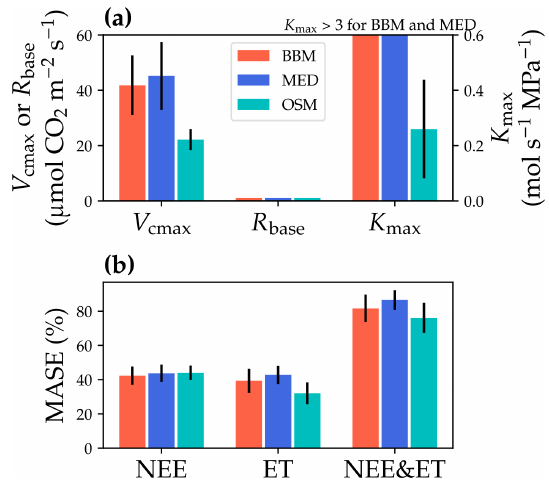
Figure 10. Comparisons of the fitted model parameters and model predictive skills for the US-NR1 (Niwot Ridge, evergreen gym- nosperm forest) flux tower. (a) The red bars plot the mean of the fitted parameters for the Ball et al. (1987) stomatal model (BBM). The fitting parameters are the maximal carboxylation rate at 25 ◦ C ( V cmax25 ), the soil respiration rate at 25 ◦ C ( R base ), and the maxi- mal whole-plant hydraulic conductance ( K max ). The blue and cyan bars plot the means for the Medlyn et al. (2011) (MED) and Wang et al. (2020) (OSM) models, respectively. Black error bars plot the standard deviation of the fitting parameter. (b) Comparison of mean absolute standardized error (MASE, Eq. 12) for the carbon flux (NEE), water flux (ET), and both NEE and ET.